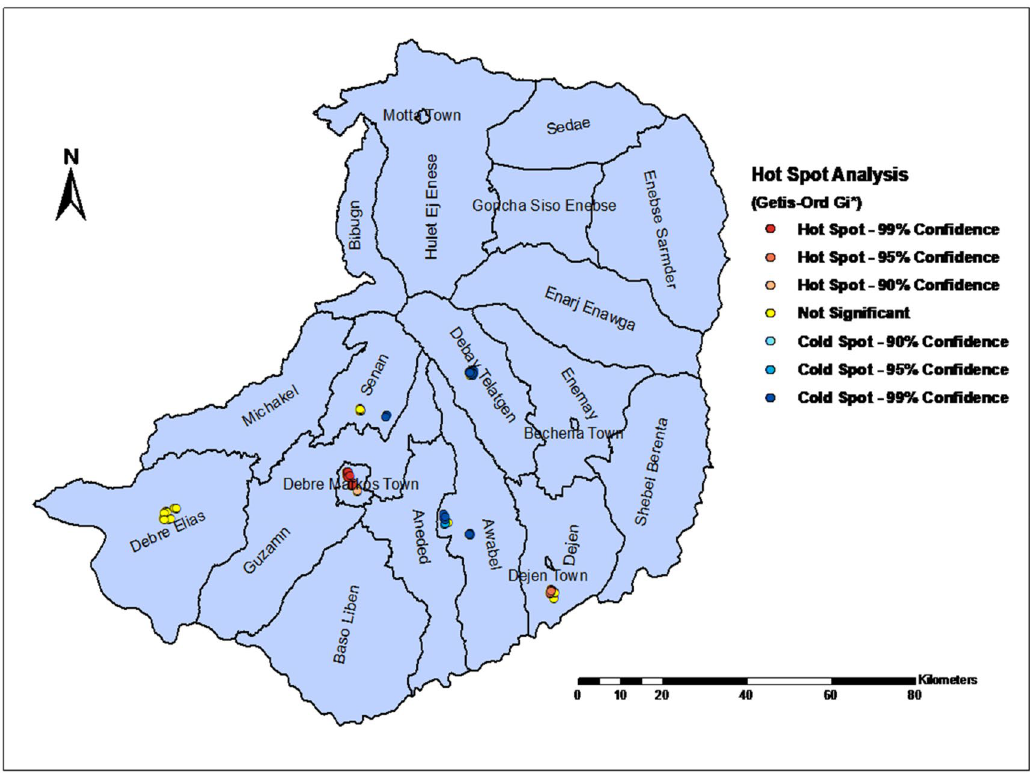
Figure 4. Hotspot areas of household non-resilience to food insecurity during COVID-19 pandemic in East Gojjam Zone, Northwest Ethiopia,